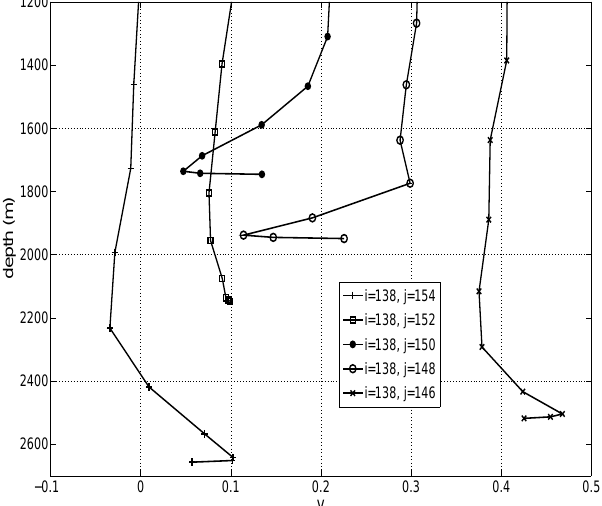
Fig. 7. Profiles of v component of velocity [ms − 1 ] at the section through the Lifamatola Passage ( i =138) from north ( j =154, left) to south ( j =146, right), represented as a thick black line in Fig. 1. Profiles are offset for clarity: for j =154 offset is 0.0ms − 1 ; for j =152 offset is 0.1ms − 1 ; for j =150 offset is 0.2ms − 1 ; for j =148 offset is 0.3ms − 1 ; for j =146 offset is 0.4ms − 1 . See Fig. 1 for i and j coordinates and Fig. 6b for profile locations. Vertical and horizontal lines are shown for